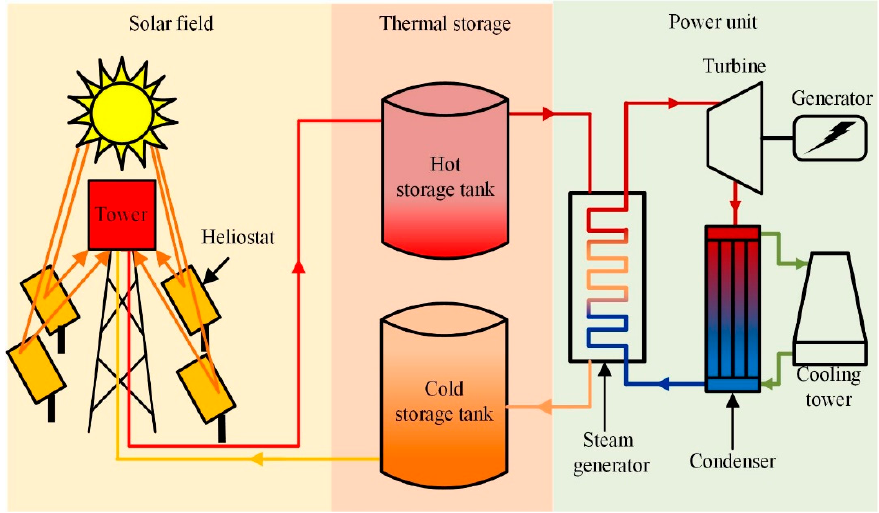
Figure 4. A schematic diagram of a solar power tower (SPT) system.